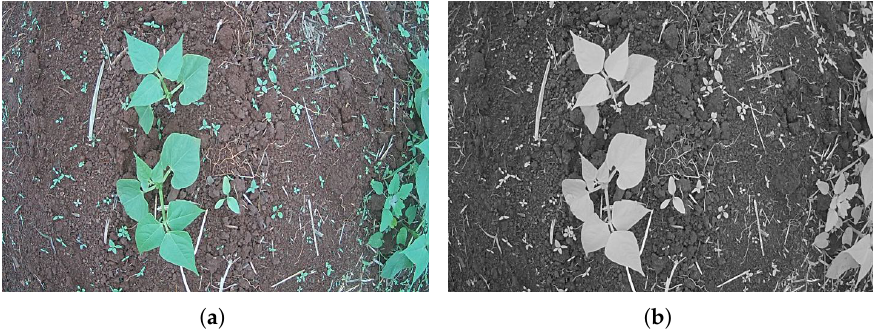
Figure 11. Examples of bean plant images acquired with DARob. ( a ) RGB image. ( b ) Infrared image.